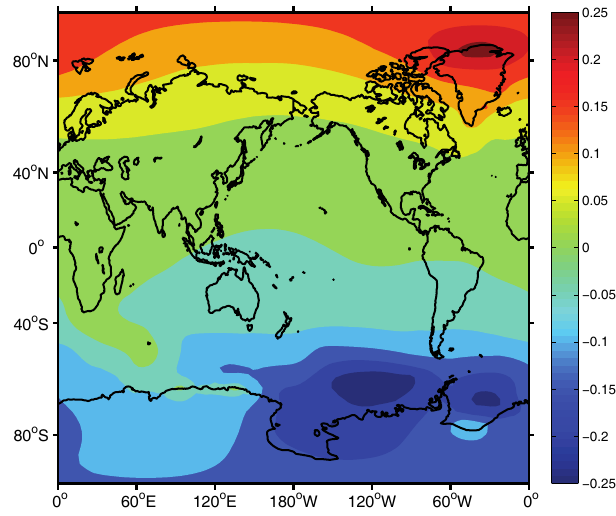
Fig. 2. The difference ( ◦ C) between annual mean UVic ESCM at- mospheric SAT fields of late Holocene simulations with/without the bias correction applied over the ice sheets. The effect of the bias correction procedure is largest over the AIS and GIS and dimin- ishes with distance from the correction regions. The global effect of the bias correction over both ice sheets is to redistribute heat from the Southern Hemisphere to the Northern Hemisphere. However, the resulting temperature change is less than 0.25 ◦ C everywhere and does not significantly affect the non-ice-sheet components of the